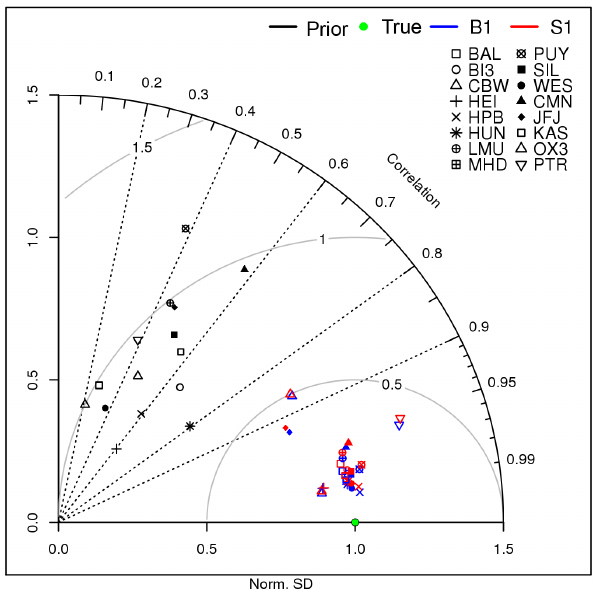
Figure 4. Taylor diagram for daily averaged modeled and measured time series (annual basis) of CO 2 dry mole fractions. Prior (black), true (green, the perfect match of modeled and true time series) and the different inversion cases (B1 blue; S1 red) are displayed. Differ- ent symbols denote different atmospheric stations. The normalized SD was calculated as the ratio of the SD of the modeled time series to the SD of observations.